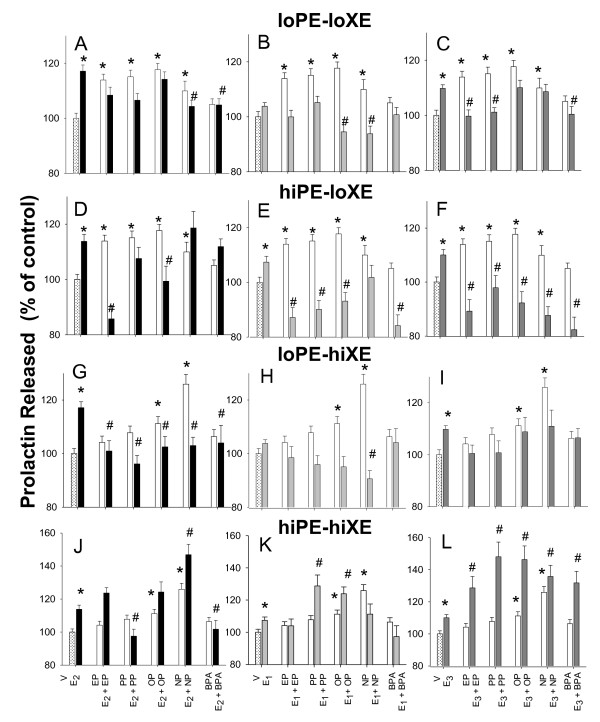
Xenoestrogens alter the amount of prolactin released by physiologic estrogens. The levels of prolactin (PRL) were measured in cells treated with (A-C) 10 pM of the physiologic estrogens (E2, E1, or E3 ) alone or in combinations with 10 pM of different alkylphenols (EP, PP, OP, NP, or BPA), row labeled lo PE - lo XE; (D-F) 1 nM of the physiologic estrogens alone or in combinations with 10 pM of different alkylphenols, row labeled hi PE - lo XE; (G-I) 10 pM of the physiologic estrogens alone or in combinations with 1 nM of different alkylphenols, row labeled lo PE - hi XE; (J-L) 1 nM of the physiologic estrogens alone or in combinations with 1 nM of different alkylphenols, row labeled hi PE - hi XE. * = p < 0.05 compared to vehicle (V) control cells. # = p < 0.05 compared to E2, E1, or E3 alone.